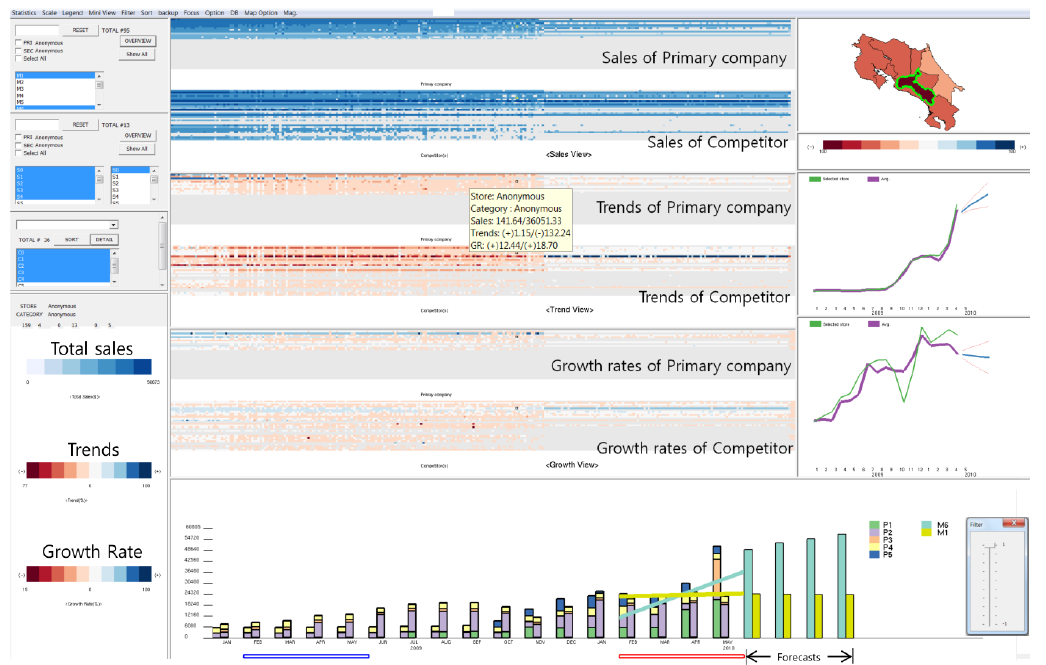
Figure 19. The main window of MarketAnalyser. The left panel contains all the filtering options and colour legends. The main screen space conveys the pixel based comparisons, and the right ride panel contains the geographical view. The bottom panel contains the stacked bar view and time sliders. Image courtesy of Ko et al.